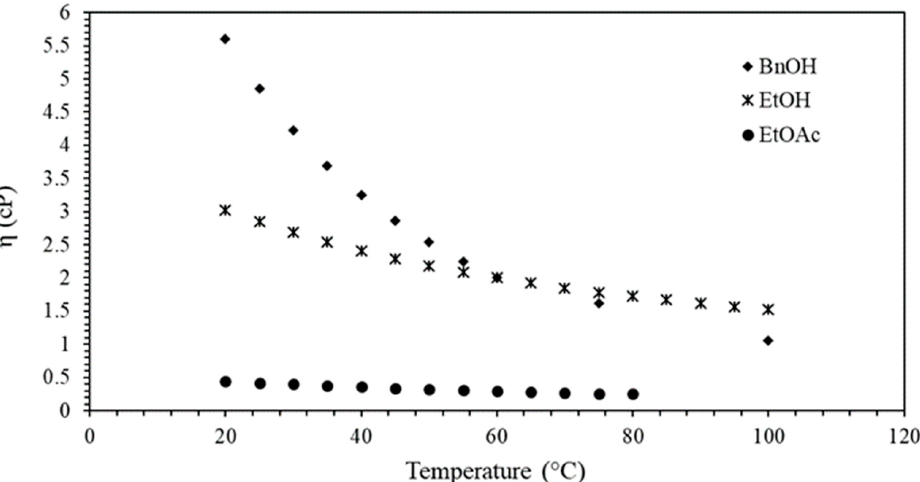
Figure 2. Temperature dependency of BnOH, EtOH, and EtOAc viscosities ( η ) at 0.1 MPa. Sources: Chemical Engineering and Material Research Information Center CHERIC [40] and Haynes [41] (pp. 6–234).